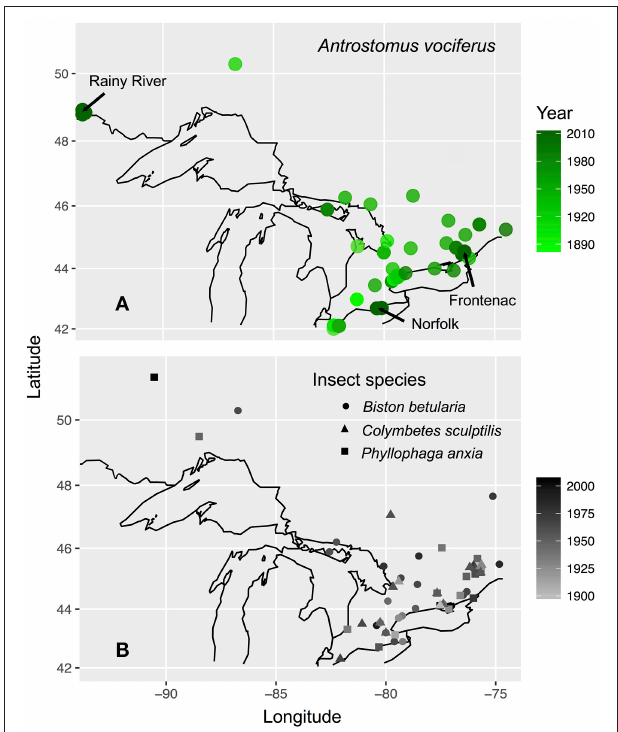
FIGURE 1 | Maps of bird (A) and insect (B) specimen and tissue collection locations in Ontario, Canada. Sites where contemporary sampling was conducted are labeled with arrows on (A) . Value shading of points indicates year collected. Black outline shows the Great Lakes and international borders from “mapdata” package (Brownrigg et al.,